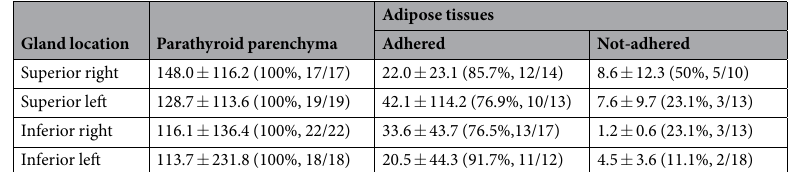
Table 2. Rate of PTH secretion in vitro according to gland locations. Shown are the rate of iPTH secretion in vitro in ng/day/0.1 g tissue (mean ± SD) and, in parentheses, percentages of specimens with iPTH secretion > 0.5 ng/day/0.1 g tissue and the number of specimens with iPTH secretion > 0.5 ng/day/0.1 g tissue over the number of specimens examined.